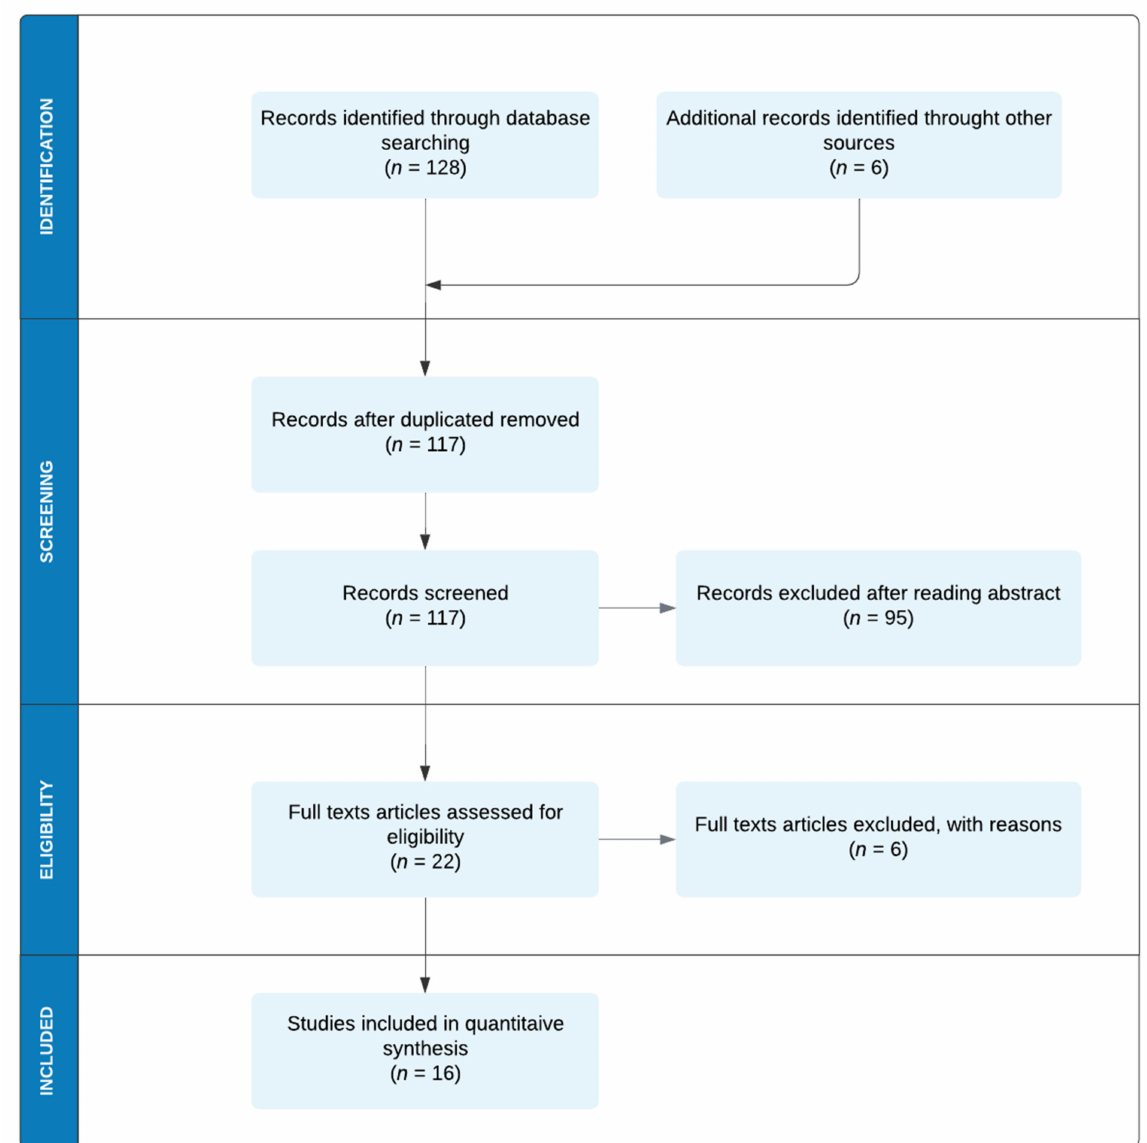
Figure 1. Flow chart of the search strategy and study selection according to PRISMA